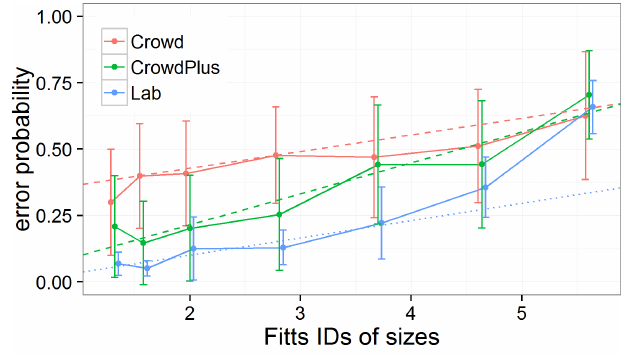
Figure 6. Target acquisition error rate by target size (in Fitts’ IDs) and group including 0.95 confidence interval error bars. Dashed slope lines include all IDs, the dotted line for the Lab had the two highest IDs excluded based on subset slope